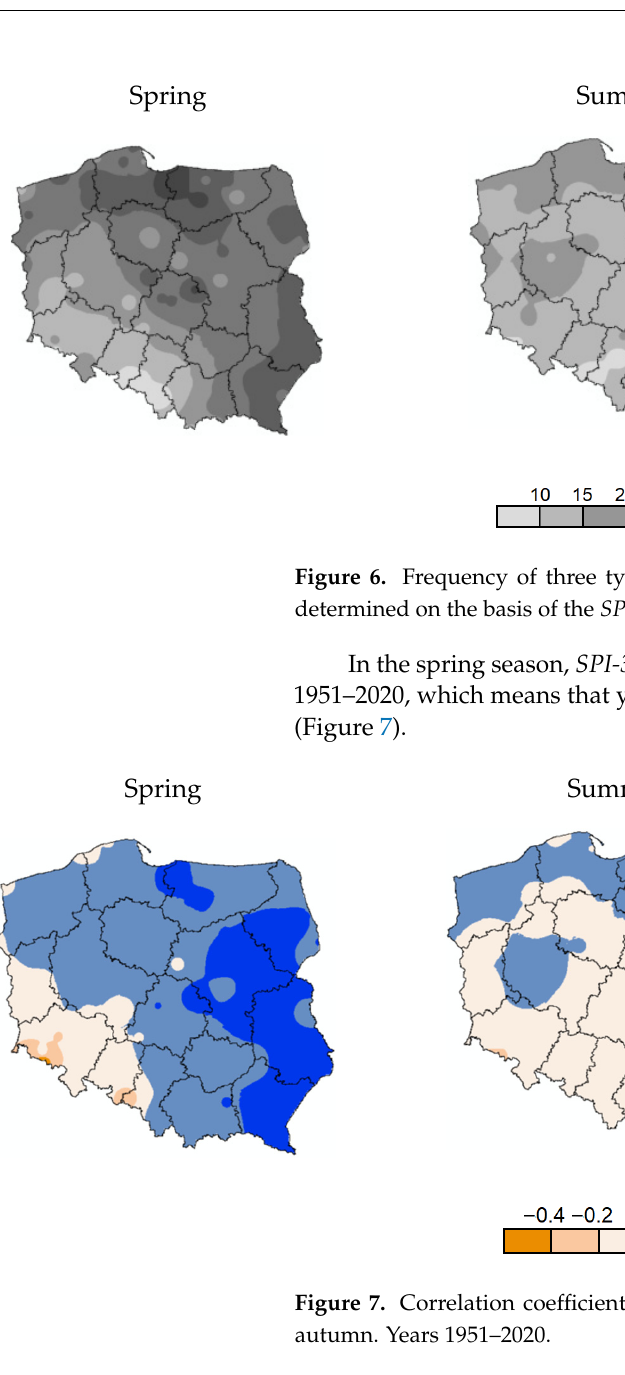
Table 2. Characteristics of Poland’s area affected by meteorological drought ( AAMDr ), determined on the basis of SPI-3 . Years 1951–2020.